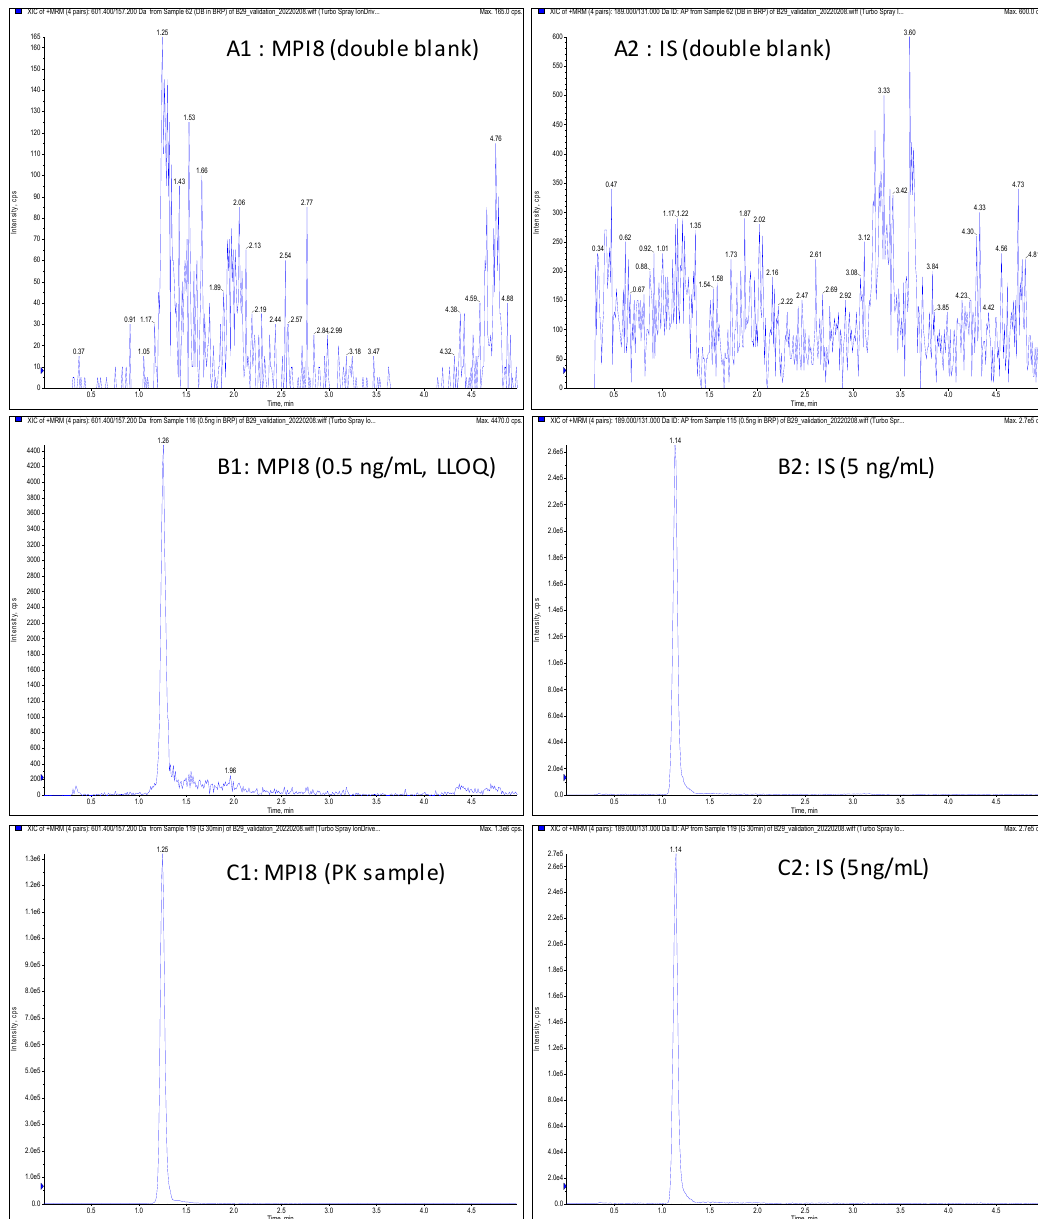
Figure 6. Representative MRM chromatograms: ( A1 ) MPI8 in double blank rat plasma, ( A2 ) IS in double blank plasma; ( B1 ) MPI8 (0.5 ng/mL) spiked in blank rat plasma, ( B2 ) IS (5 ng/mL) spiked in blank rat plasma; ( C1 ) MPI8 in a rat plasma sample at 30 min after IV administration of MPI8 sulfonate at a single dose of 5 mg/kg, ( C2 ) IS (5ng/mL) in a rat plasma sample at 30 min after IV administration of MPI8 sulfonate at a single dose of 5 mg/kg. There was no interference at the retention times of the analyte and IS, and no carryover for both IS ( ≤ 5% of average response) and MPI8 ( ≤ 20% of LLOQ).